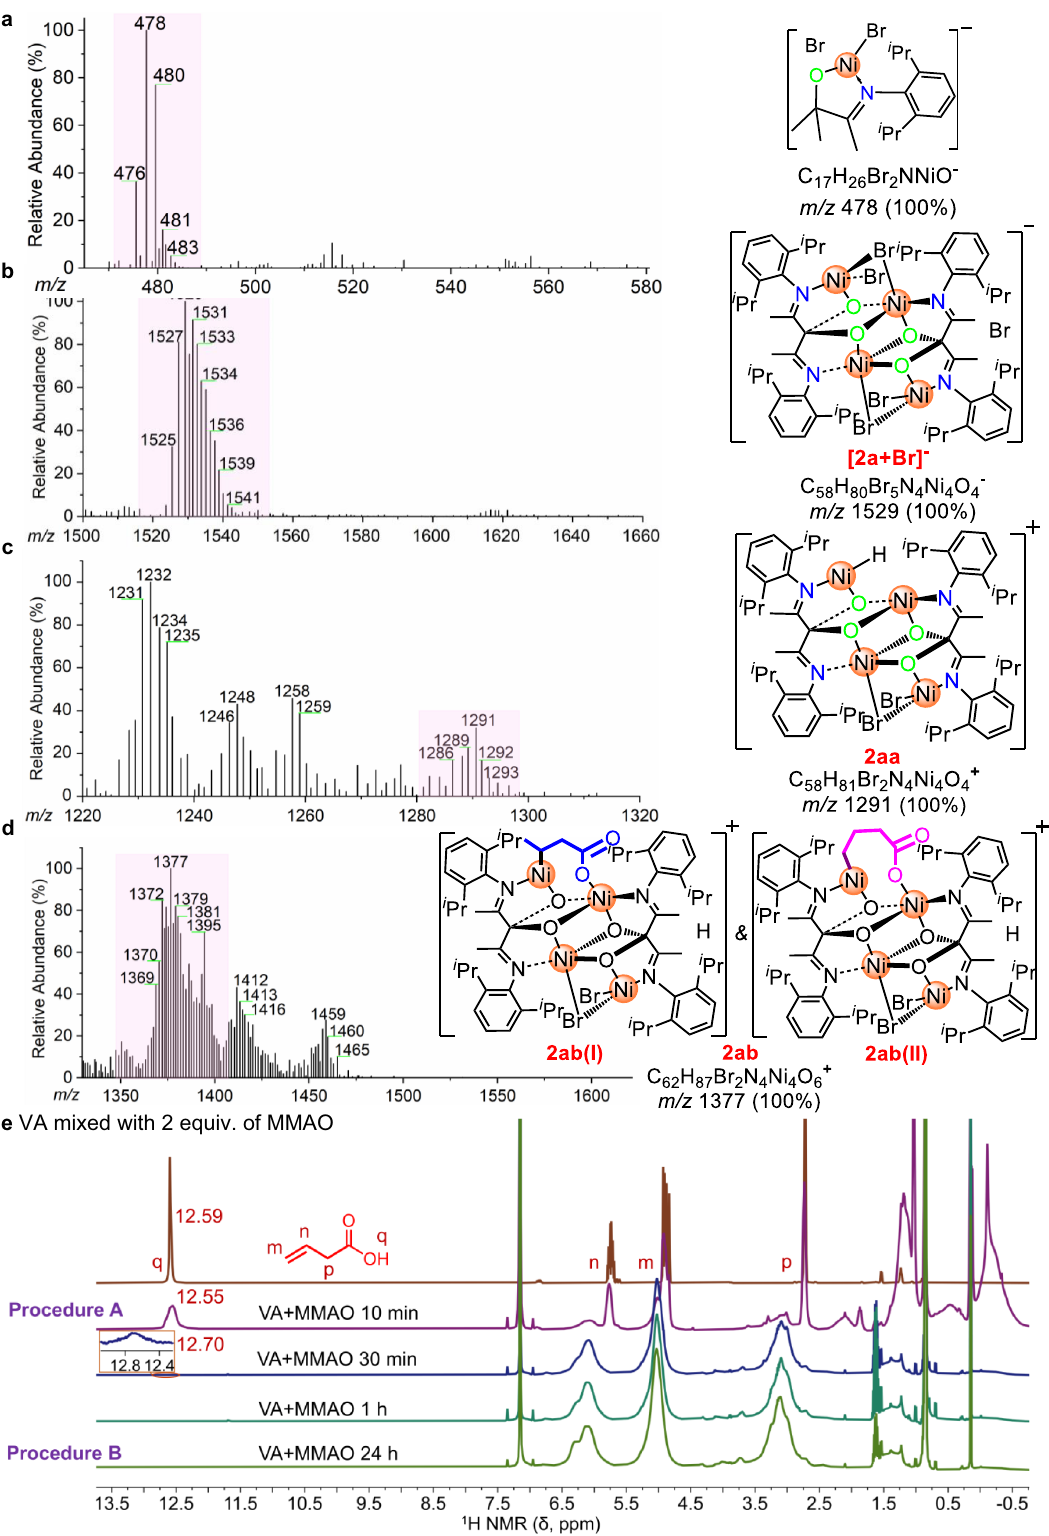
Fig. 2 SAESI-MS and NMR spectra. a SAESI-MS spectra of 7 in DCM showing signals at m/z 478 [(0.5) 7 + Br] - . b SAESI-MS spectra of 2a showing signals of [ 2a + Br] - . c SAESI-MS spectra of 2a /MMAO showing signals of [ 2a -2Br + H] + ( 2aa ). d SAESI-MS spectra of 2a /MMAO/VA showing signals of [ 2a -2Br + H + VA] + ( 2ab ). e 1 H NMR tracking reaction mimicking polar monomer pretreatment procedures (in C 6 D 6 , 25 o C).